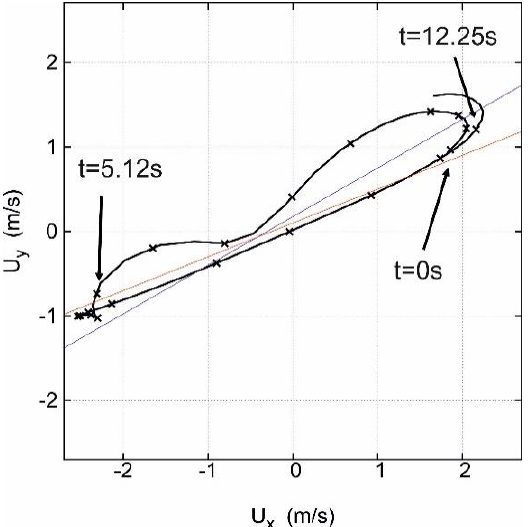
Figure 5. Temporal evolution of the representation of (U x , U y ) extracted at a location point with coordinates (1°57.66’W; 49°44.83’N) during the tidal cycle ( tidal rose). Dots correspond to the 20 time- varying flow conditions given in Table 2. The water depth at the extraction point varies between 52.92 and 57.15 m.